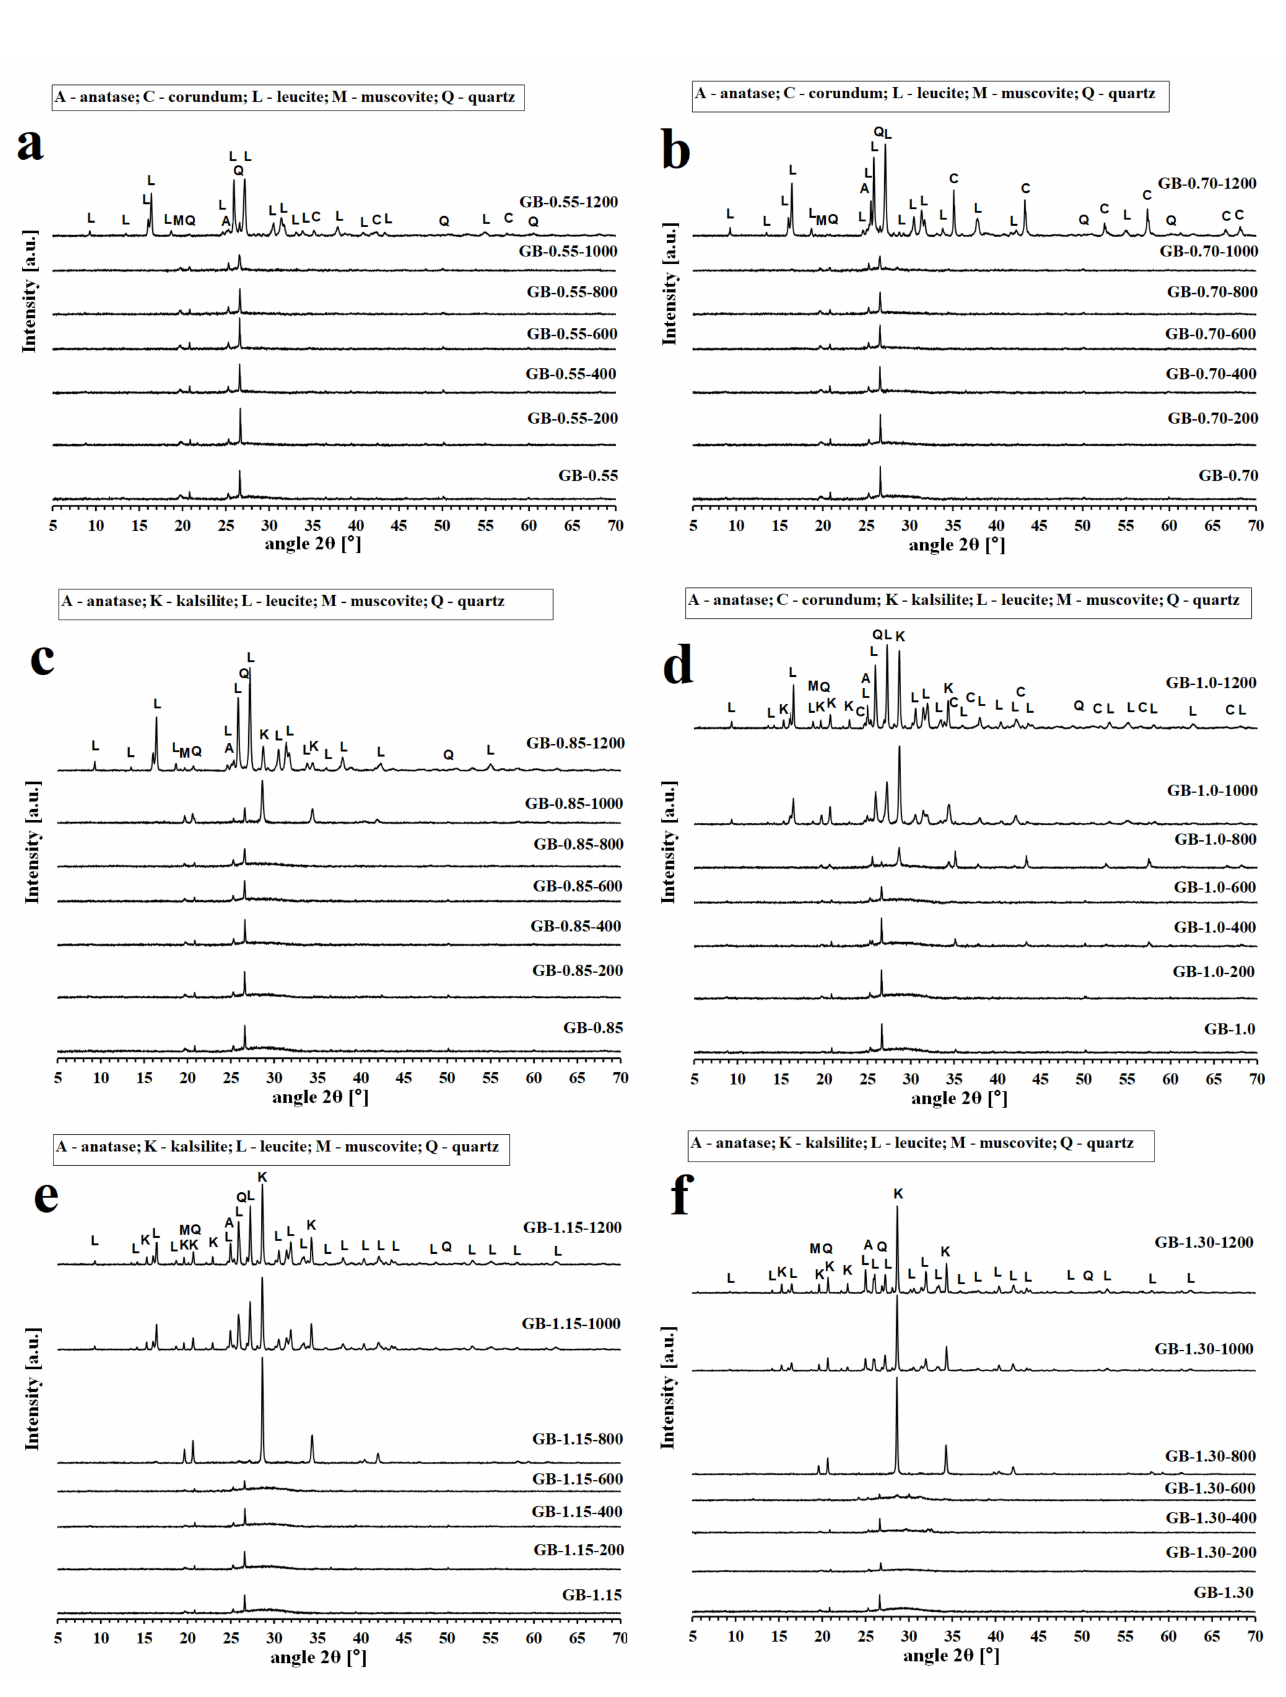
Figure 2. XRD patterns of the geopolymer binders with various molar ratios of K/Al (( a )—GB-0.55, ( b )—GB-0.70, ( c )—GB- 0.85, ( d )—-1.0, ( e )—GB-1.15, ( f )—GB-1.30) at laboratory temperature and after exposure up to 1200 ◦